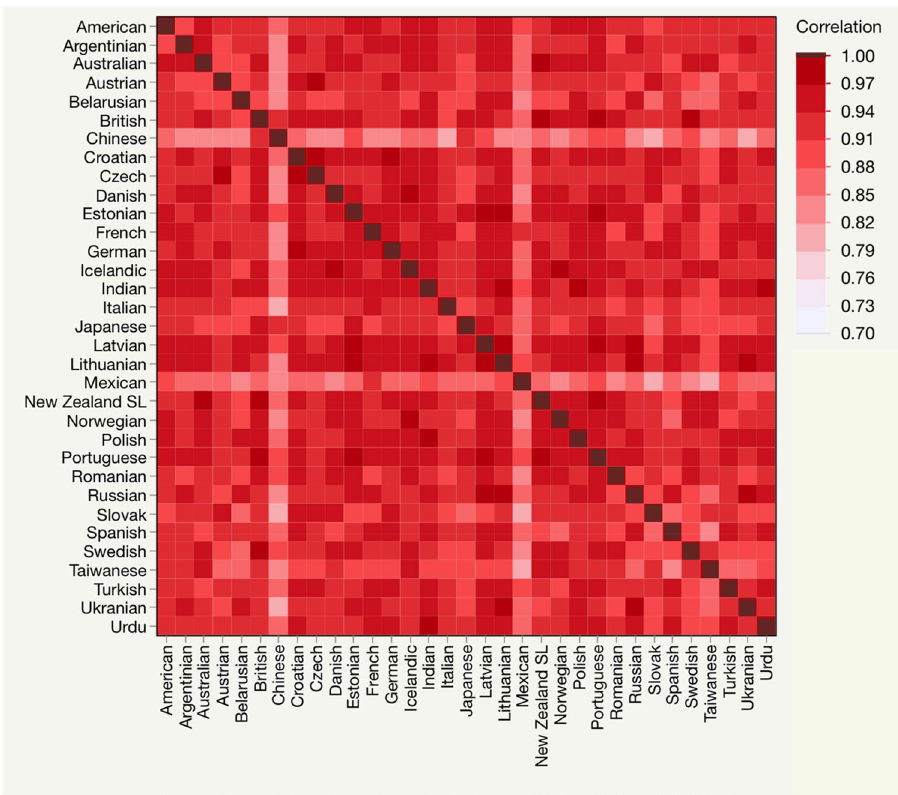
Figure 4. The heat map shows the correlation coefficients resulting from correlating the frequencies of the 160 handshapes between each language pair. Handshape frequencies were strongly correlated across languages (mean r = 0.925; range